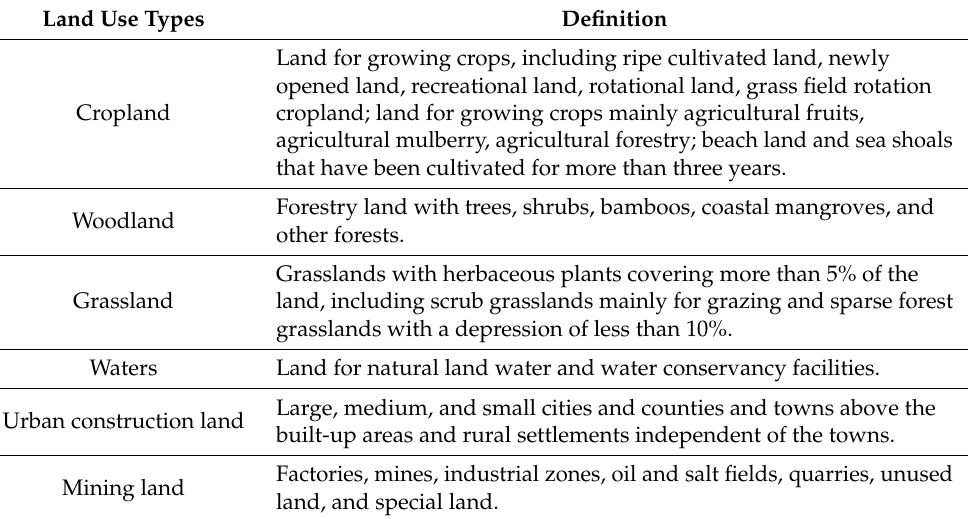
Table 1. Land use